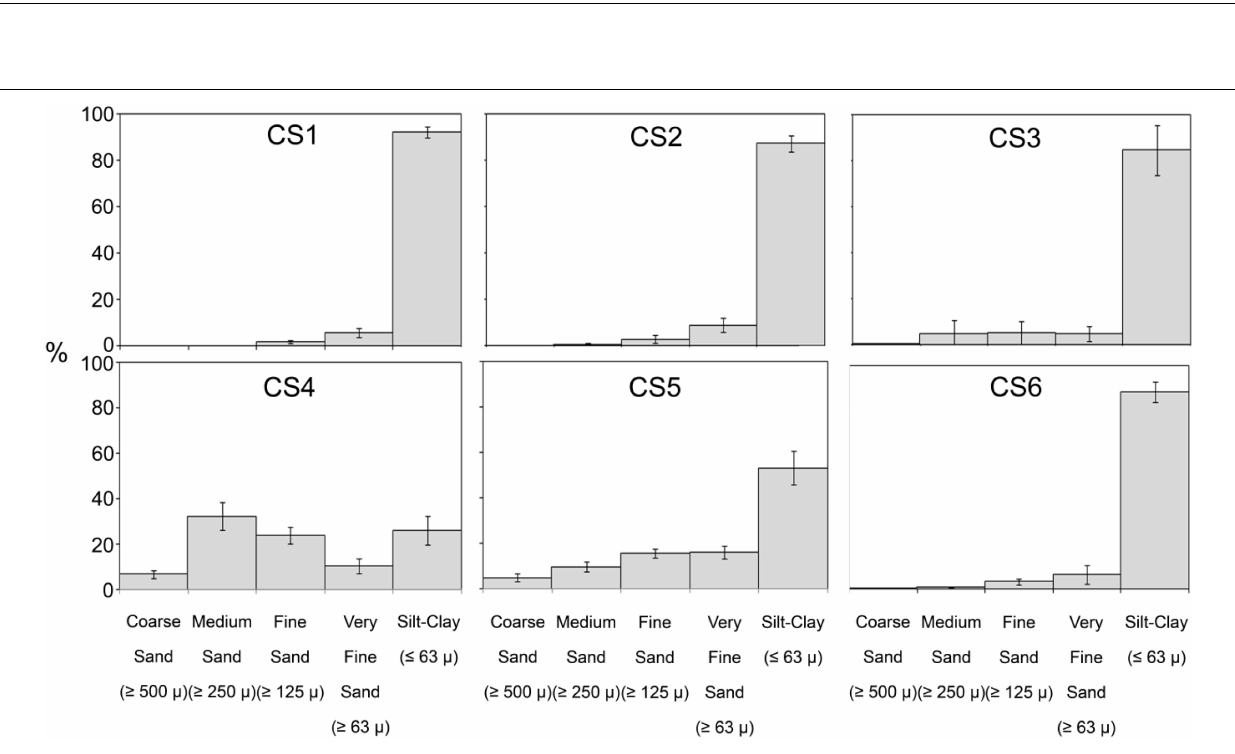
Frontiers in Marine Science |